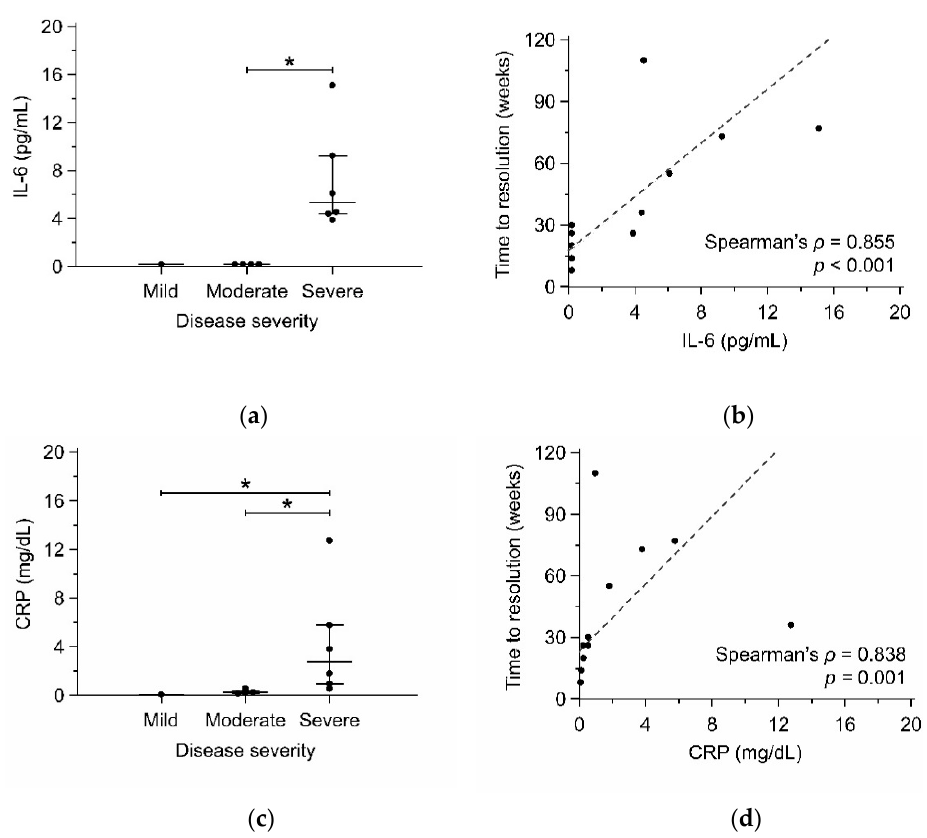
Figure 2. Serum IL-6 ( a ) and CRP ( c ) levels among IGM patients with mild, moderate, and severe disease were compared using the Kruskal–Wallis test and post hoc Dunn’s test. Spearman’s correlation coefficient was calculated to determine the correlation of serum IL-6 ( b ) and CRP ( d ) levels and time to resolution. Scatter diagrams and reduced major axis regression (dashed line) were displayed. * p < 0.05; CRP, C-reactive protein; IGM, idiopathic granulomatous mastitis; IL-6, interleukin-6.